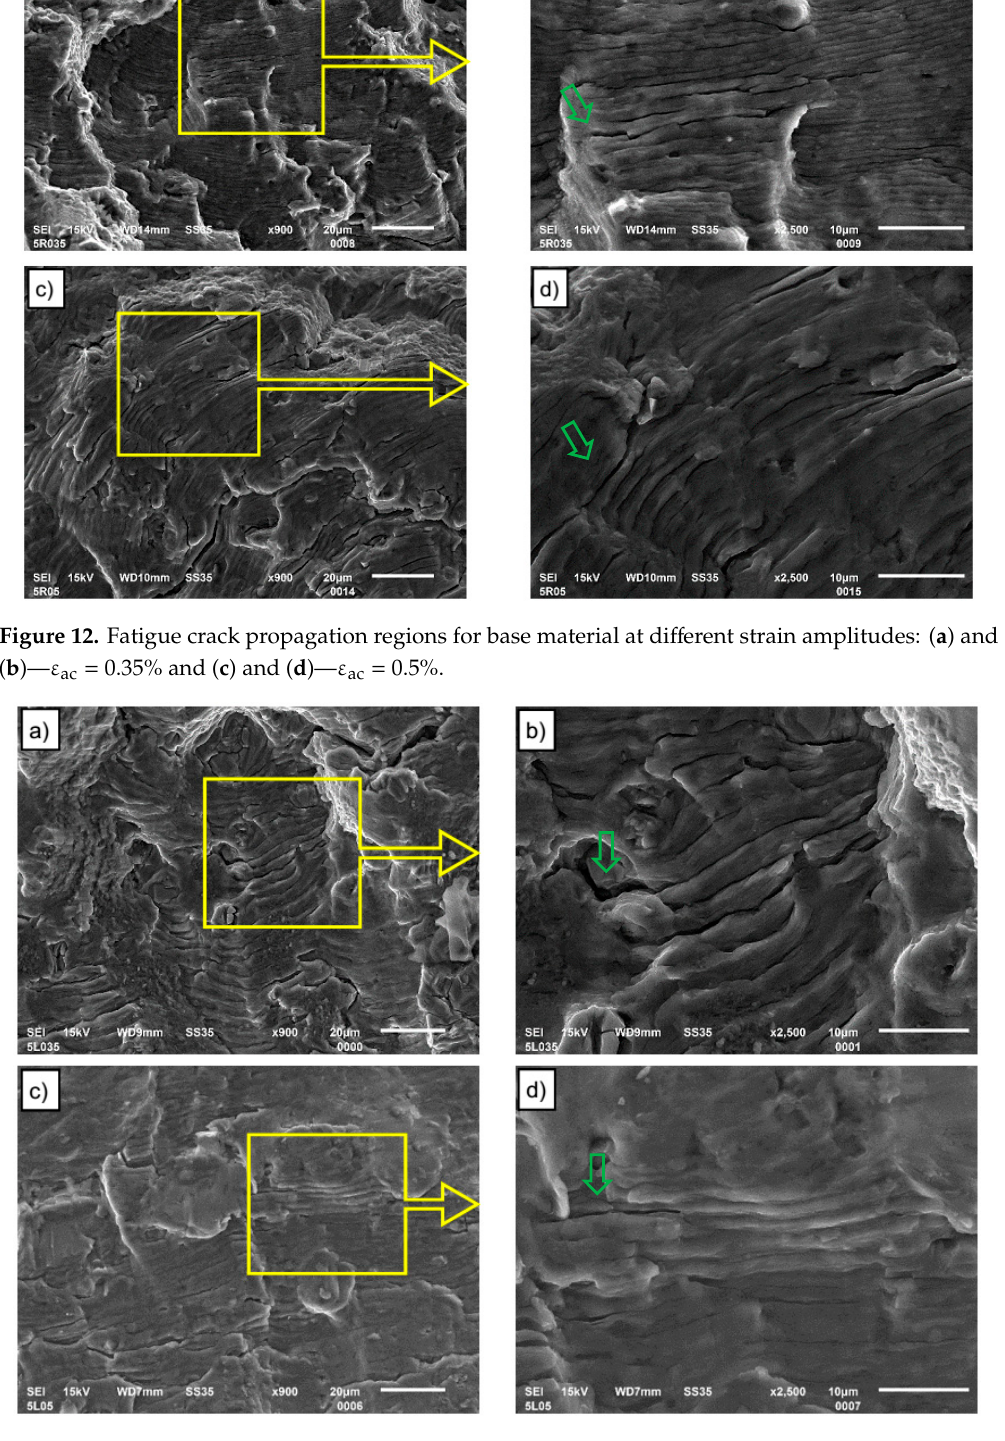
for base material (Figure 12) than for FSW joints (Figure